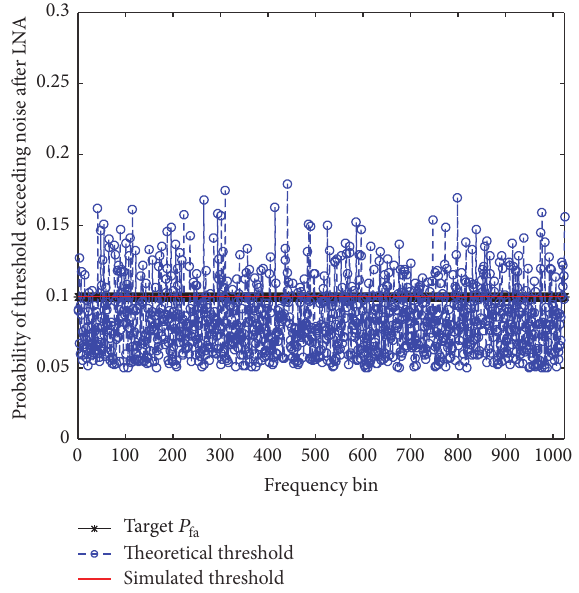
Figure 16: Probability of threshold being exceeded only in presence of noise at 𝑃 fa = 0.1 .